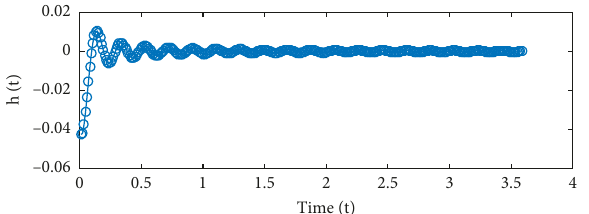
Figure 12: The interpolation function in equation